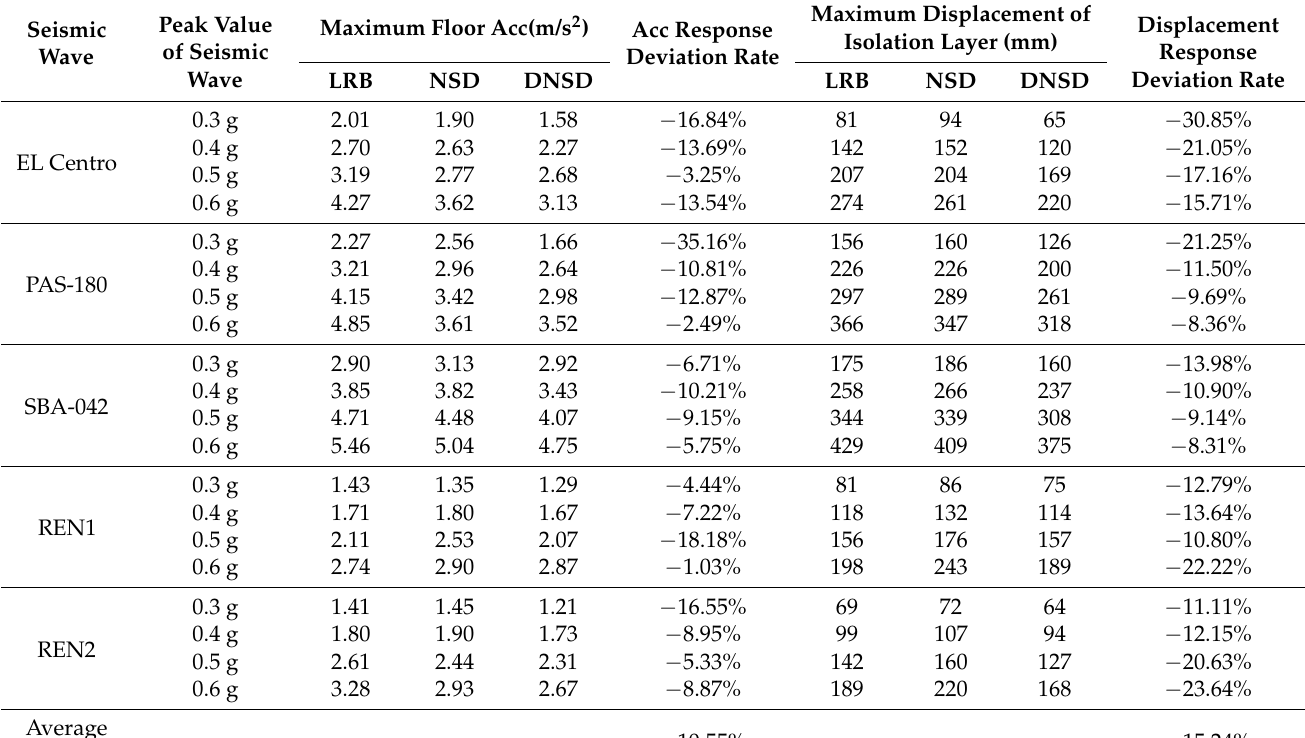
Table 5. Summary of time history results under the action of local seismic waves (NSD vs.